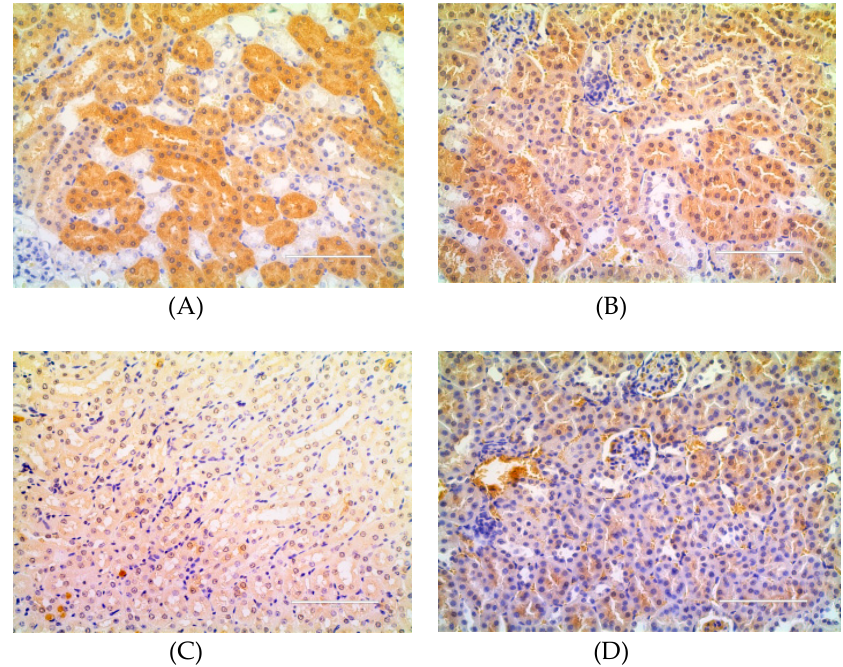
Figure 7. Expression of tumor necrosis factor- α (TNF- α ) in kidney tissue detected by immunohistochemistry. The positive expressive areas of TNF- α are tan. ( A ) DM group; ( B ) DMMET130 group; ( C ) Control group; ( D ) DMDJP100 group. Table 3. Immunohistochemical expression of TNF- α of liver/ kidney tissue in the mice. Group Expression of TNF- α in Liver Tissue Expression of TNF- α in Kidney Tissue